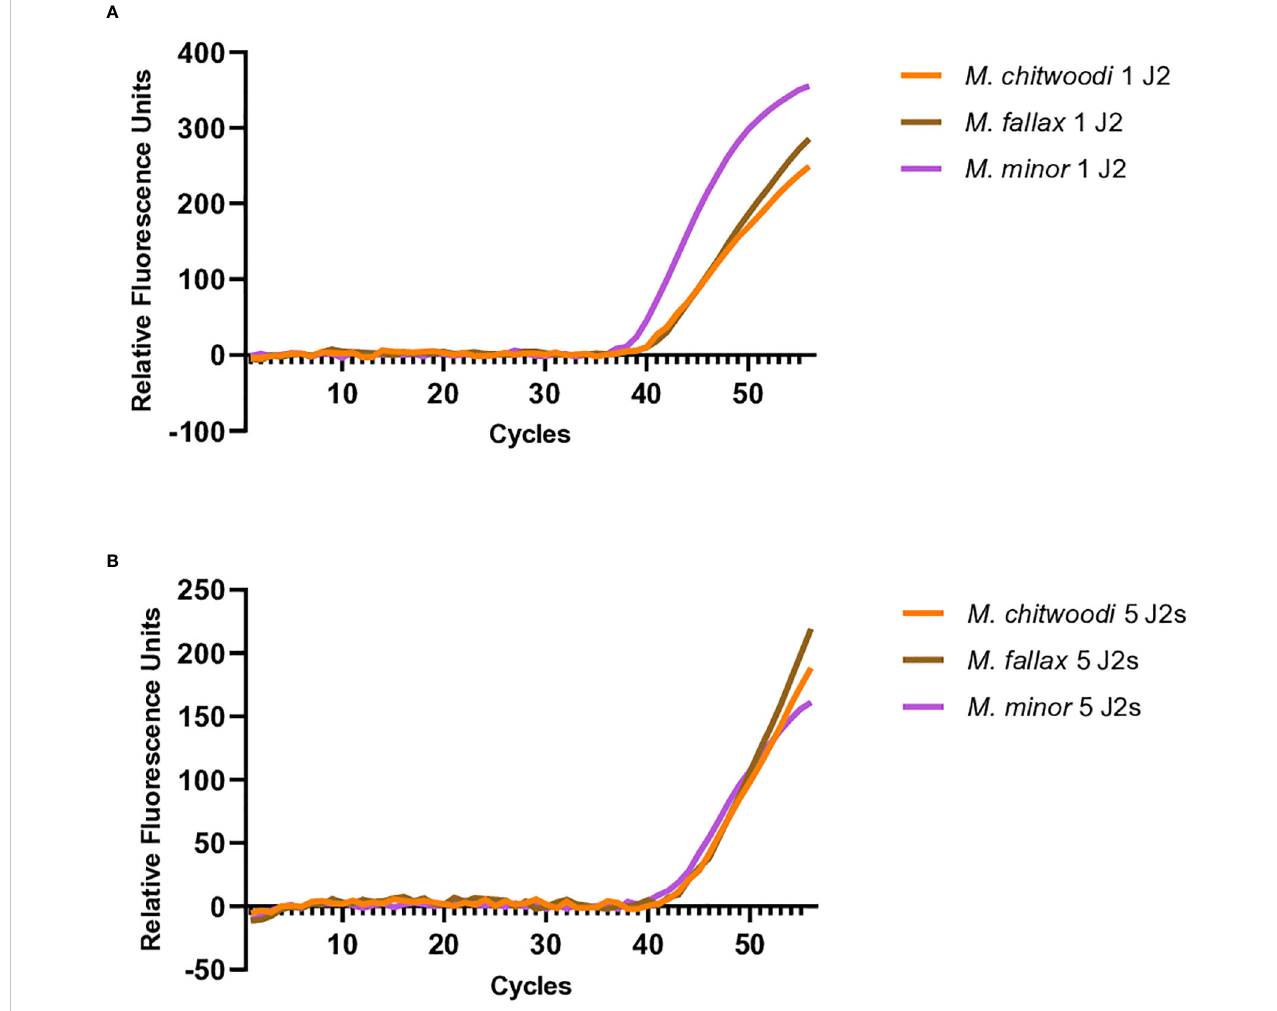
FIGURE 6 Multiplexed molecular beacon RT-PCR assays containing an equal mix of 1 or 5 J2s from M. chitwoodi , M. fallax , and M. minor as template. (A) Ampli fi cation curves from 1 J2 of M. chitwoodi (average Ct = 42.3, SEM = 0.43, n = 10), M. fallax (average Ct = 43.7, SEM = 0.78, n = 10), and M. minor (average Ct = 41.1, SEM = 0.69, n = 10) in a single reaction. (B) Ampli fi cation curves from 5 J2s of M. chitwoodi (average Ct = 42.4, SEM = 0.63, n = 4), M. fallax (average Ct = 42.7, SEM = 0.92, n = 4), and M. minor (average Ct = 42.7, SEM = 0.62, n = 4) in a single